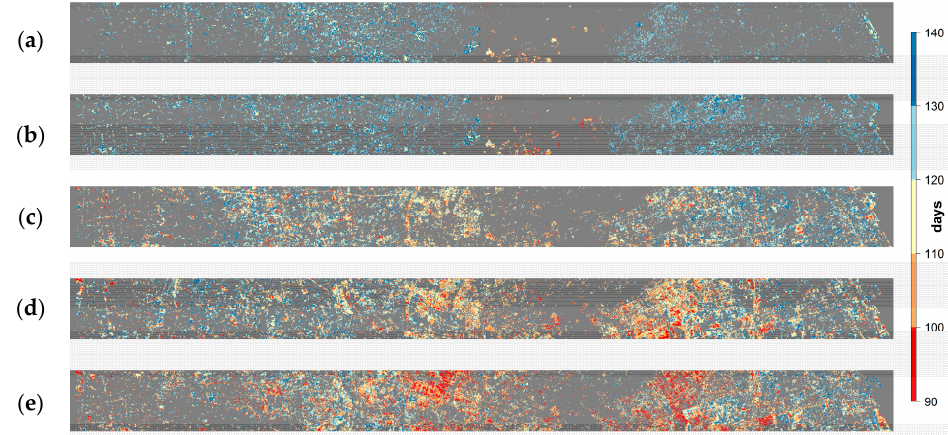
Figure 4. Spatial pattern of mean SOS for urban vegetation along the east-west transect for the five periods: ( a ) 1984–1995; ( b ) 1996–2000; ( c ) 2001–2005; ( d ) 2006–2010 and ( e ) 2011–2015.